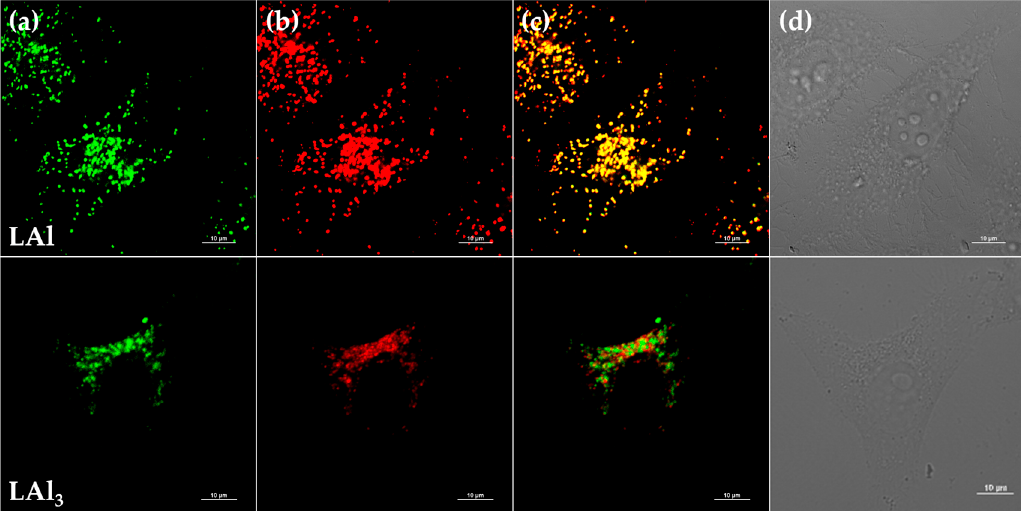
Figure 5. Co-localization studies of the two Al salophen complexes and LysoTracker Red: ( a ) images of the two compounds indicated; ( b ) images of LysoTracker Red; ( c ) merged images of ( a , b ); ( d ) Differential interference contrast (DIC). 5 µ M Al salophens were incubated with HeLa cells for 12 h and then 50 nm LysoTracker Red was incubated with HeLa cells for 20 min. Scale bar: 10 µ m.